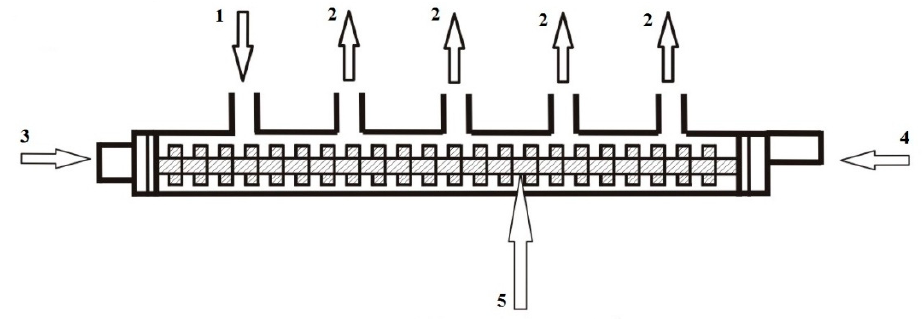
Figure 1. Modified common rail (CR) high-pressure battery: 1—fuel supply to the rail, 2—output for fuel injectors, 3—high-pressure sensor, 4—high-pressure regulator, 5—catalytic reactor.